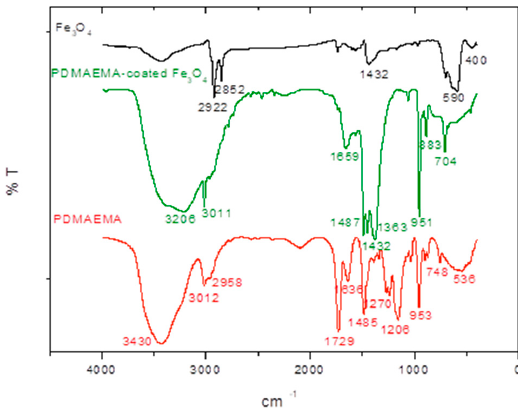
Figure 4. FTIR spectra of Fe 3 O 4 particles, PDMAEMA and PDMAEMA-coated Fe 3 O 4 particles.